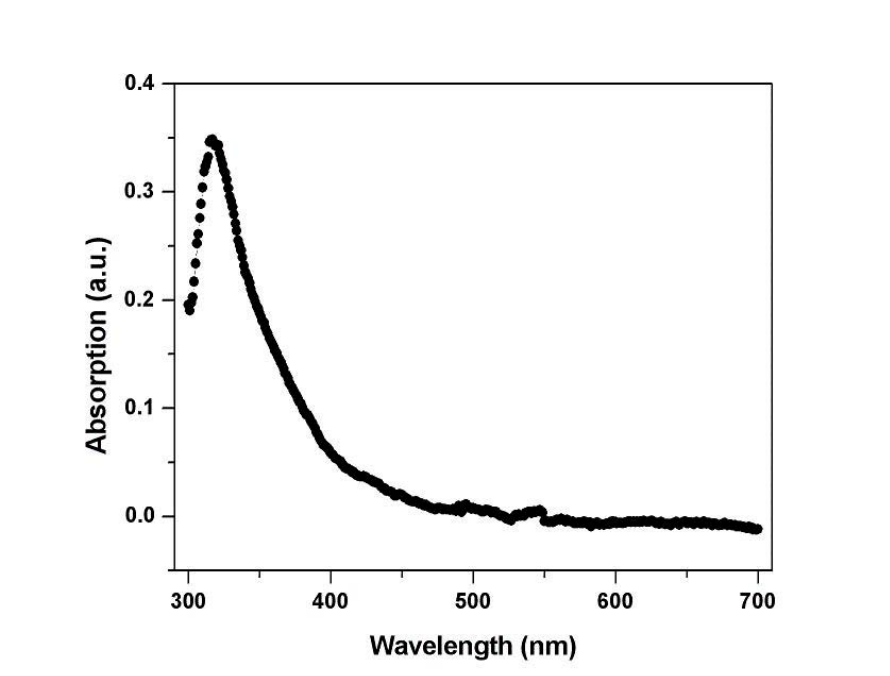
Figure 12. Absorption spectrum obtained for sample 2 using the LDR